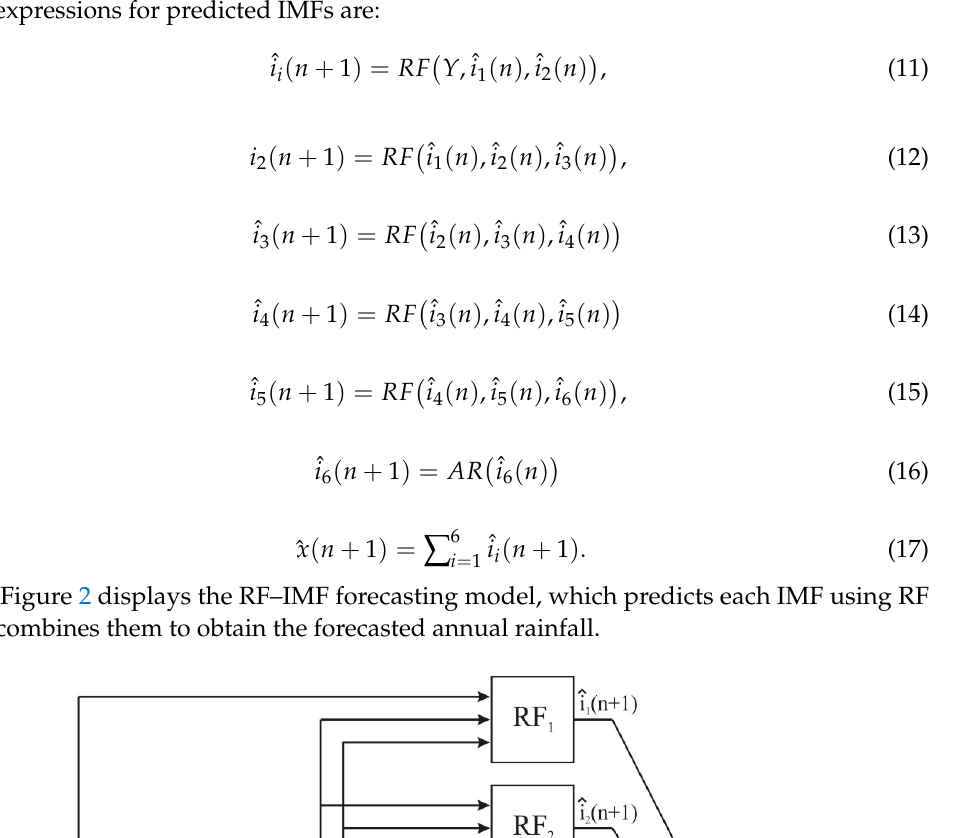
The algorithm for prediction using RFIMF is given below: